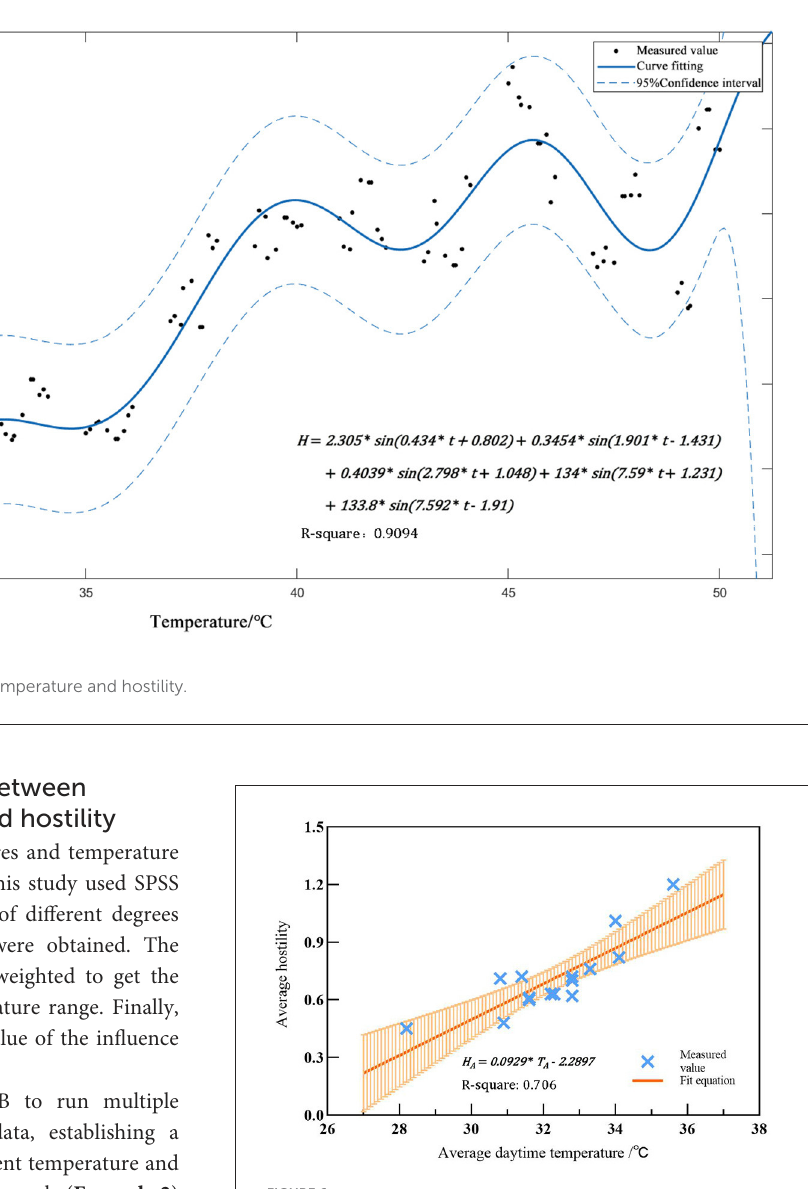
FIGURE6 The relationship model between the average temperature during the day and the average